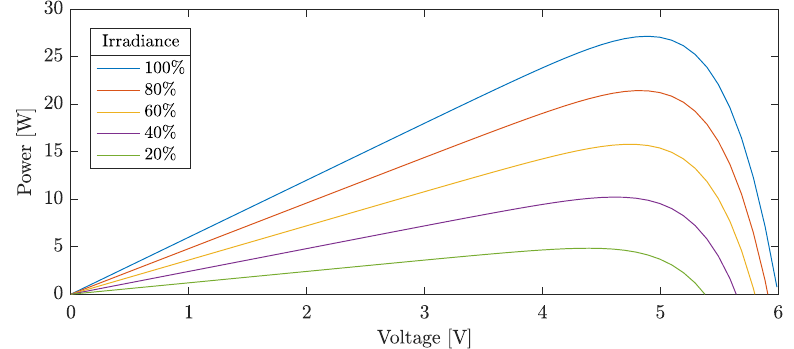
Figure 9. Simulation setup for obtaining output power vs. output voltage curves. Temperature of the cells is 25 degrees.